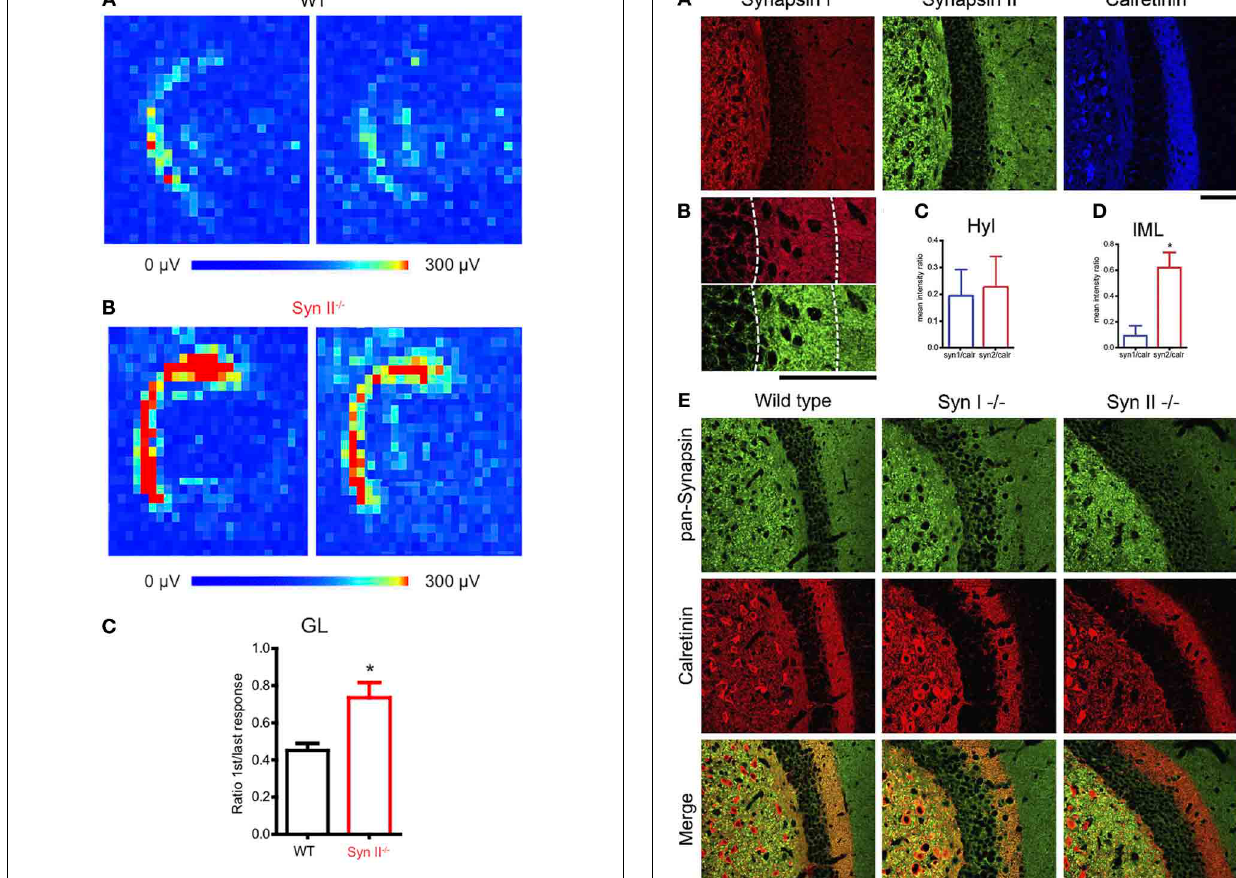
FIGURE 2 | Perforant path depression is reduced in slices from young Syn II − / − mice. (A,B) Color-coded fPSP activity on a selected area on the APS-MEA chip representing the response of the DG granule layer from WT (A) and pre-symptomatic Syn II − / − (B) slices to the first (left) and the last (right) perforant path extracellular stimulation in a train of 5s at 20Hz. (C) Mean ( ± s.e.m.) ratio between the mean granule layer amplitude of the first and the last response in the train for both genotypes; ∗ p < 0 . 05, two-tailed unpaired Student’s t -test.